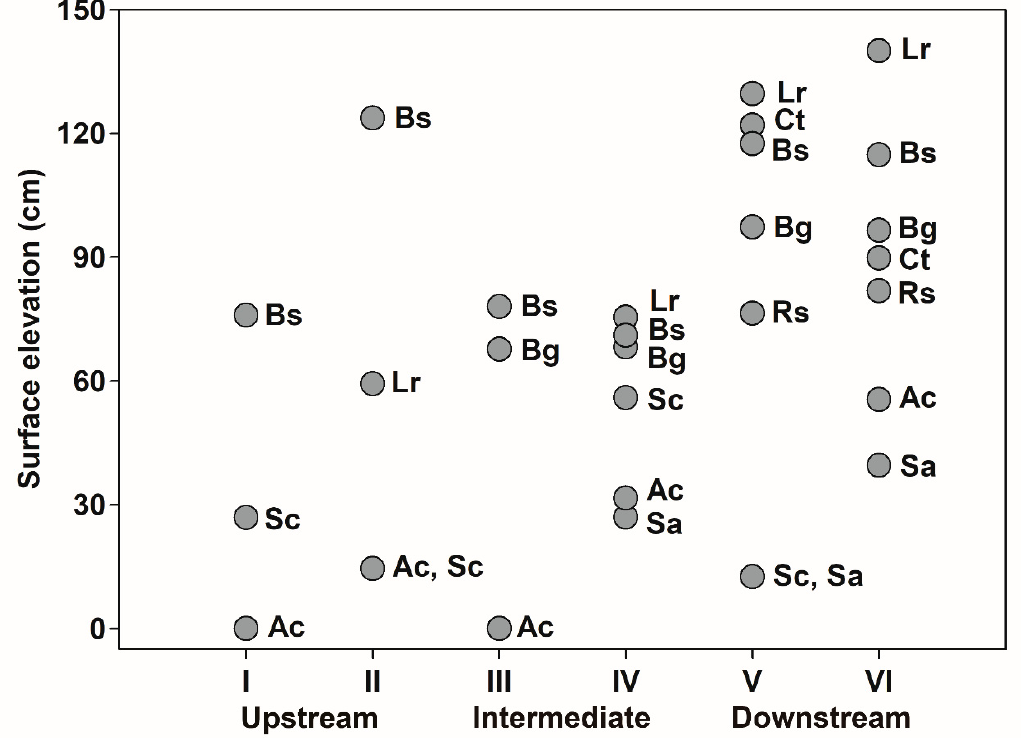
Figure 5. Surface elevations of eight mangrove species in different transects along the Wenchang River. Ac: Aegiceras corniculatum , Bg: Bruguiera gymnorhiza , Bs: Bruguiera sexangula , Ct: Ceriops tagal , Lr: Lumnitzera racemosa , Rs: Rhizophora stylosa , Sa: Sonneratia alba , Sc: Sonneratia caseolaris.